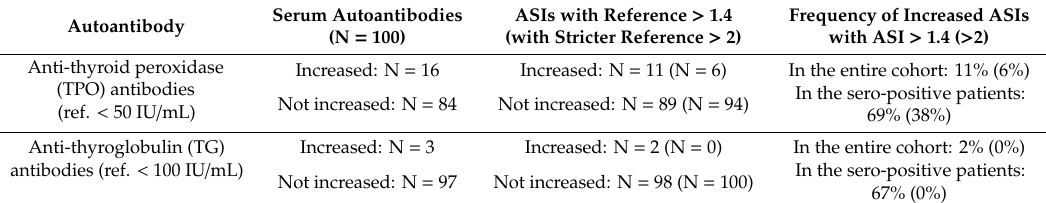
Table 1. Anti-thyroid autoantibody findings in the whole group of patients with depressive disorders.